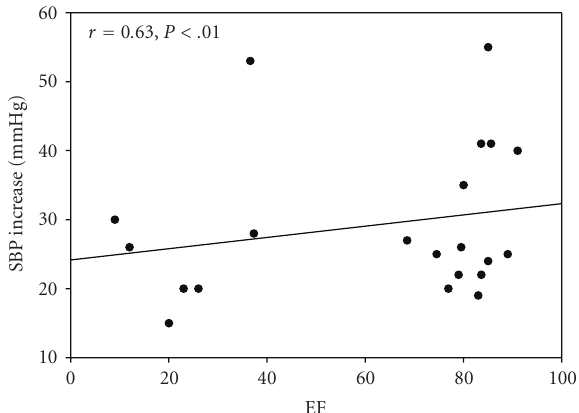
Figure 5: Scatterplot illustrating the relationship between EF and SBP increase. EF: Exertion Fatigue, SBP: Systolic Blood Pressure, and mmHg: Millimeter of